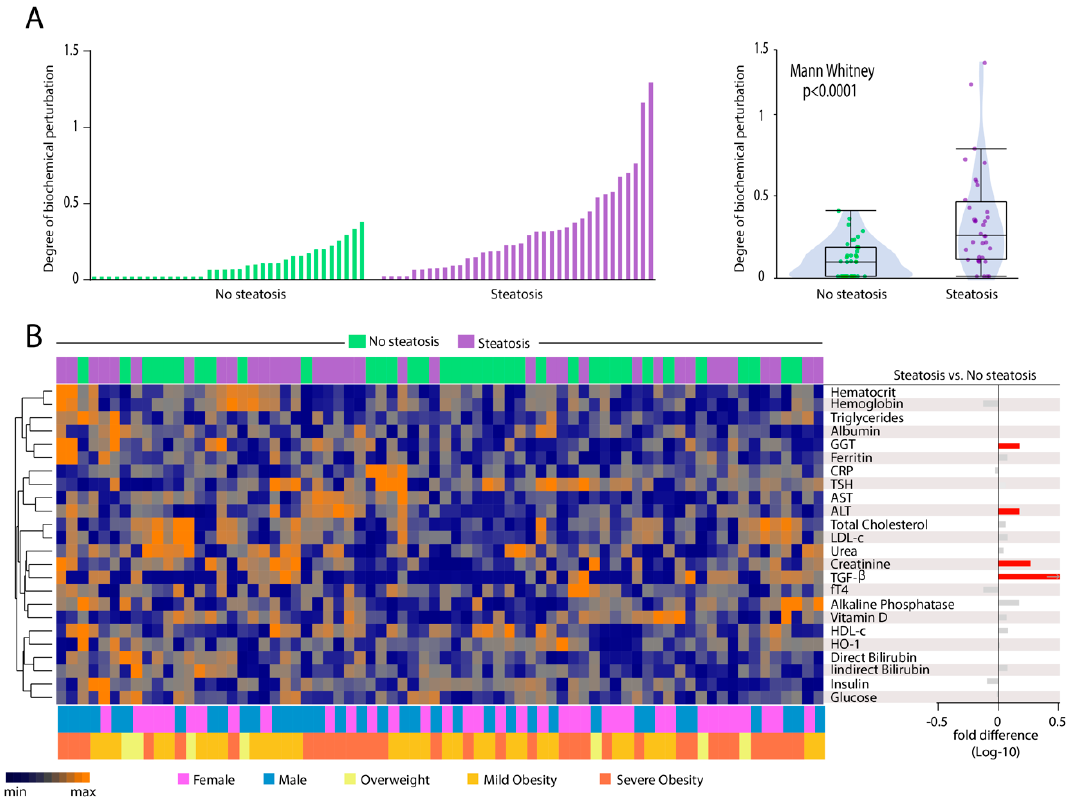
Figure 4. Hepatic steatosis is associated with increases in degree of biochemical perturbation. ( A ) Left panel: Histograms show the single sample degree of biochemical perturbation (DBP) score values relative to each study group as indicated. Right panel: Box plots represent the distribution of the DBP between study groups. Values were compared between patients with and without steatosis using Mann Whitney U test. ( B ) Left panel: A hierarchical cluster analysis (Ward’s method) was employed to show the molecular degree of perturbation of each biochemical marker. Right panel: Average fold-di ff erence values in DBP for patients with hepatic steatosis and without steatosis group. Abbreviations (alphabetic order): ALT: alanine aminotransferase; AST: aspartate aminotransferase; CRP: C-reactive protein;